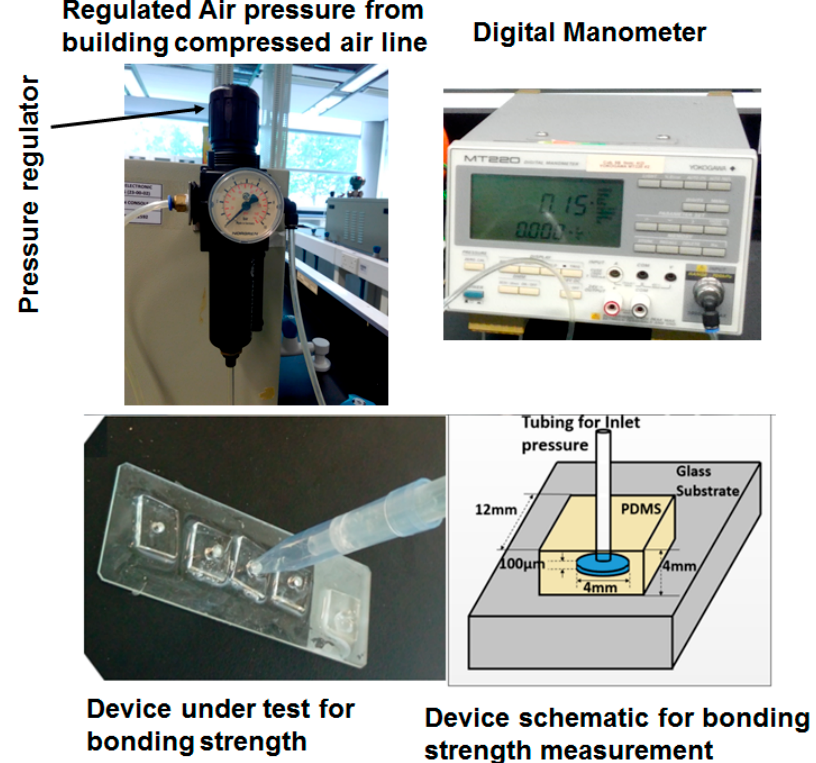
Figure 2. Setup for measuring bonding strength using the building compressed air line and digital manometer.